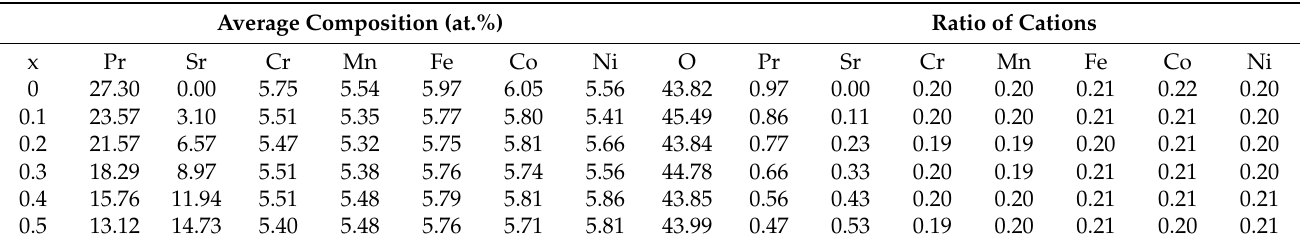
Table A5. Average composition of Pr 1– x Sr x (Cr,Mn,Fe,Co,Ni)O 3– δ ( x = 0–0.5) obtained on an effec- tive area of 336µm 2 by silicon drift detectors. Average Composition